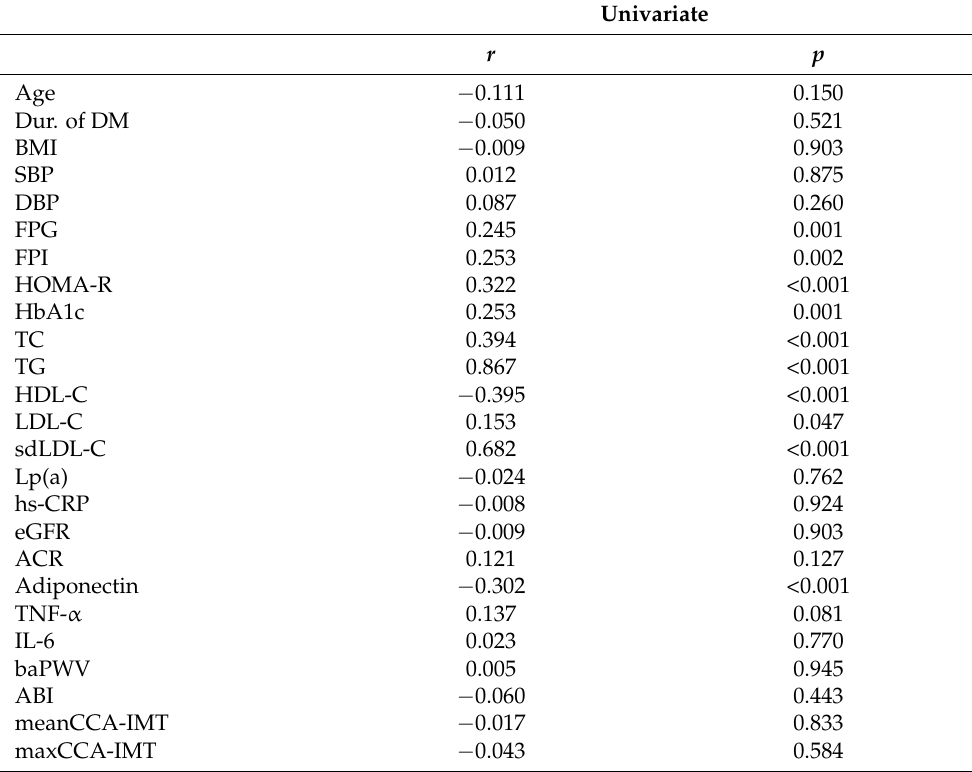
Table 2. Relationships between RemL-C and clinical parameters in patients with